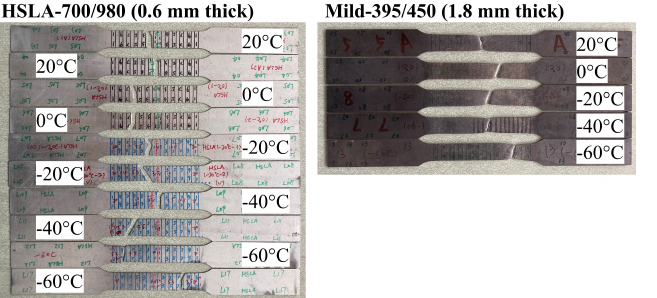
Figure 4. The failure modes of AHSS specimens at fracture. Necking is observed in DP-580/980 specimens.